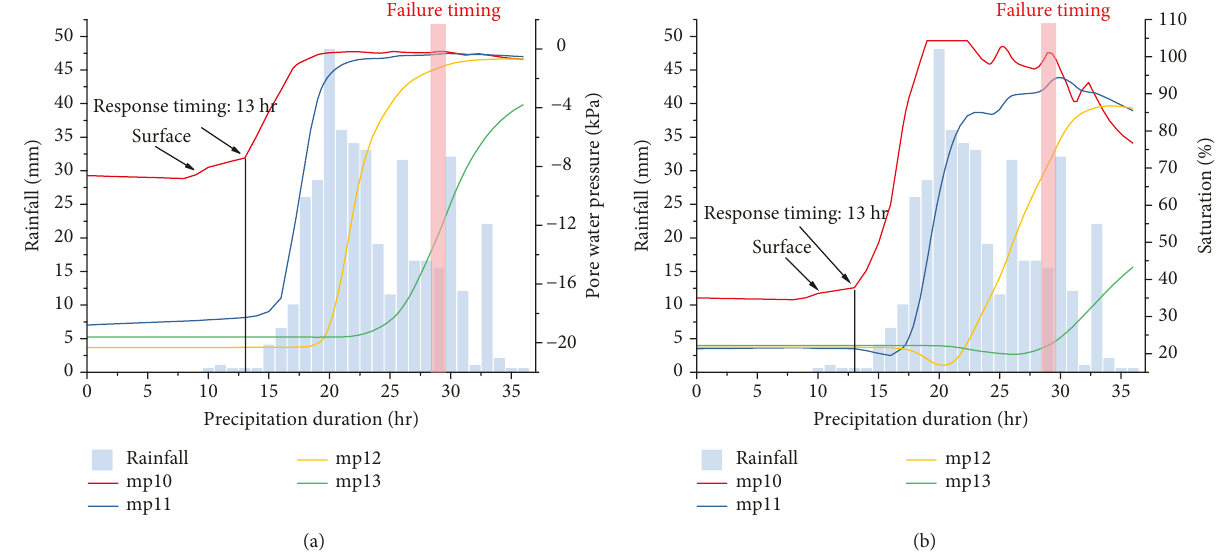
Figure 10: (a) The variation of the pore water pressure for monitoring points: mp10 – 13. (b) The variation of the saturation for monitoring points: mp10 – 13.